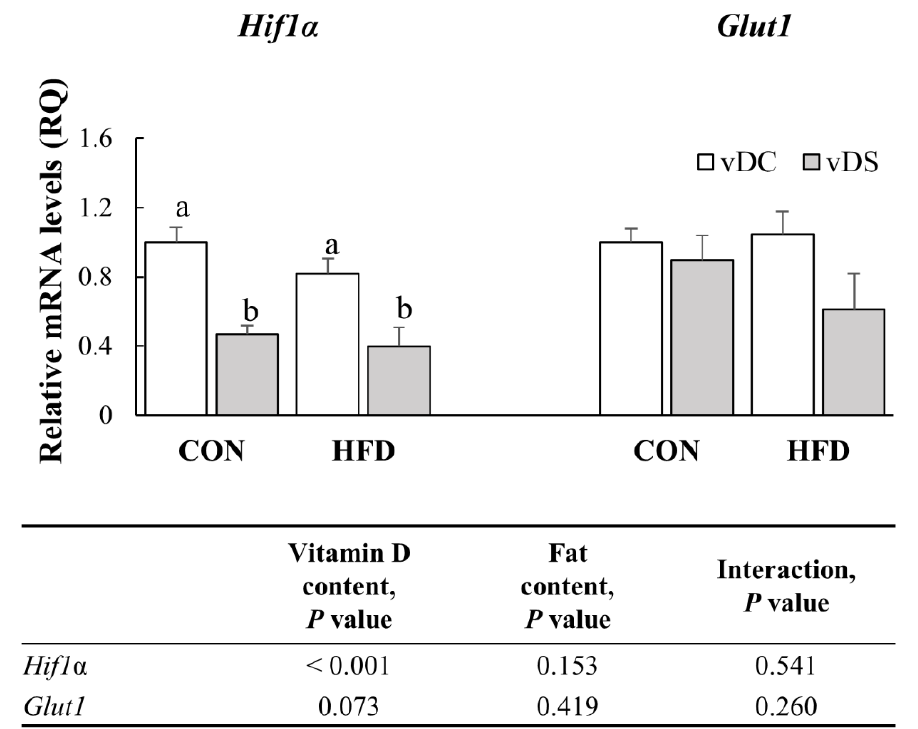
Figure 7. mRNA levels of Hif1 α and Glut1 in T cells. Splenic T cells were stimulated with anti- CD3/anti-CD28 mAbs for 48 h, and the mRNA levels of Hif1 α and Glut1 were determined by qPCR. Data are presented as means ± SEMs, n = 7–9 per group. Two-way ANOVA was used to determine the significant effects of fat and vitamin D contents, and an interaction. a,b Different superscripts indicate significant difference ( p < 0.05) among individual groups, by Fisher’s least significant difference multiple comparison test. All values were normalized to the levels of housekeeping gene Gapdh and expressed as relative mRNA levels, compared with the average levels of the CON-vDC group. CON-vDC, 10% kcal fat diet + vitamin D control; CON-vDS, 10% kcal fat diet + vitamin D supplemented; HFD-vDC, 45% kcal fat diet + vitamin D control; HFD-vDS, 45% kcal fat diet + vitamin D